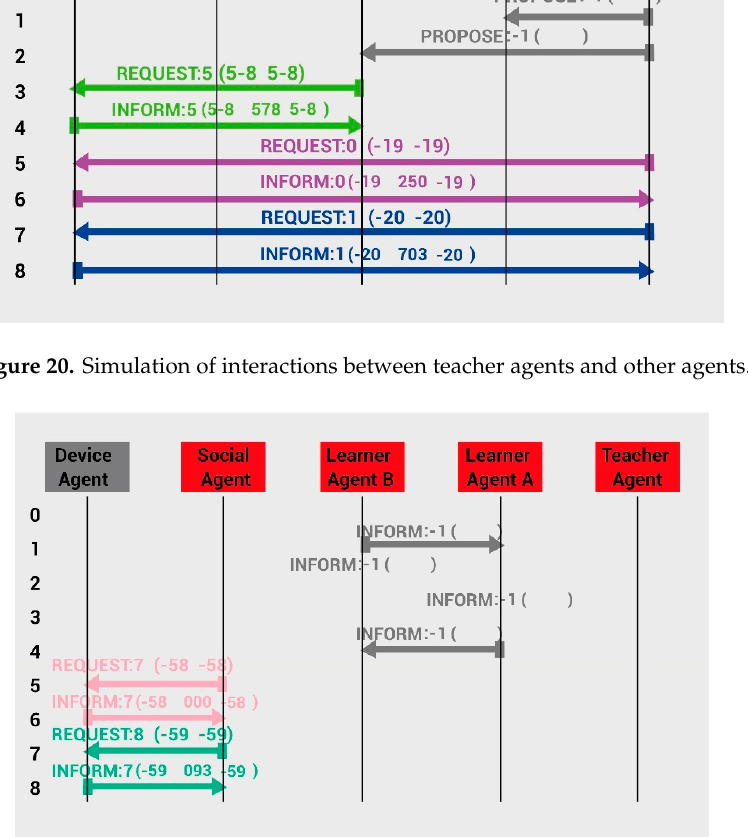
Figure 21. Simulation of interactions between learner agents.